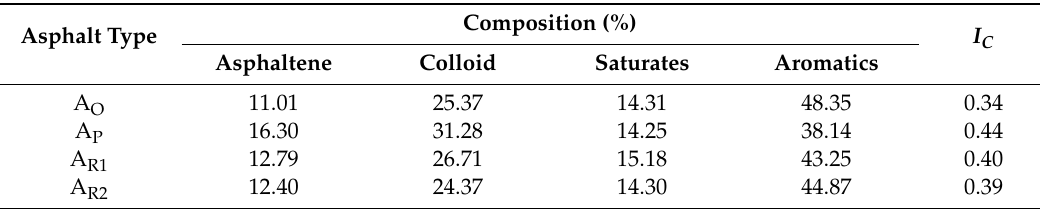
Table 7. Composition and gel index of each